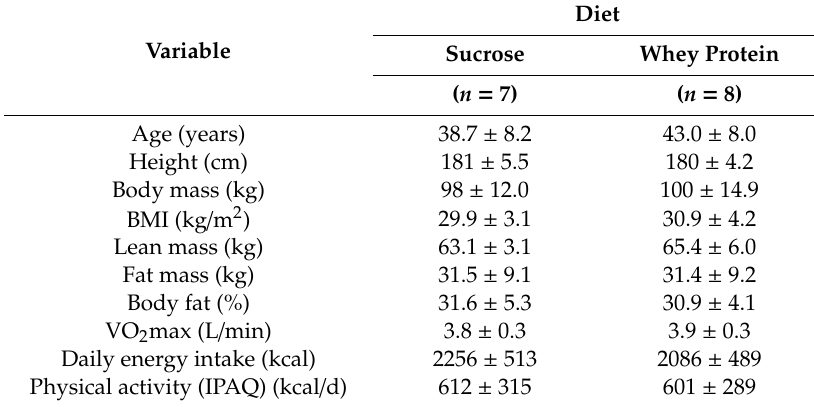
Table 1. Characteristics of the overweight and obese male participants included in the study. Variable